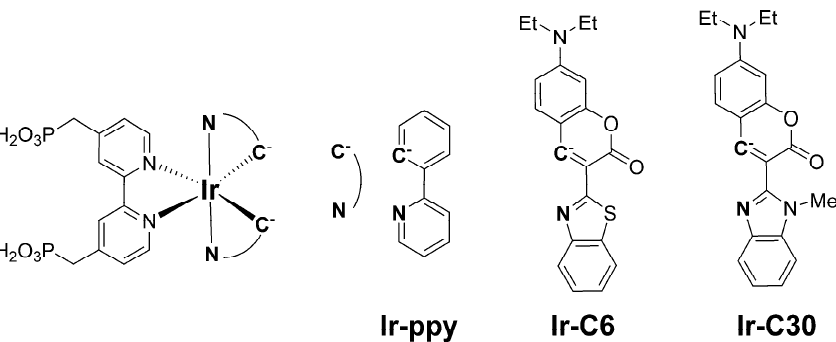
Figure 1. Molecular structures of the Ir(III) complexes [Ir(ppy) 2 (H 4 CPbpy)] + (Ir-ppy), [Ir(C6) 2 (H 4 CPbpy)] + (Ir-C6), and [Ir(C30) 2 (H 4 CPbpy)] + (Ir-C30).